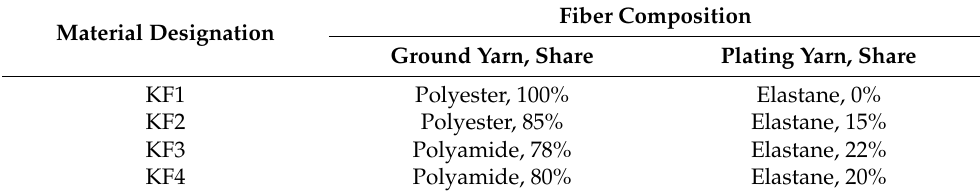
Table 1. Parameters of a set of